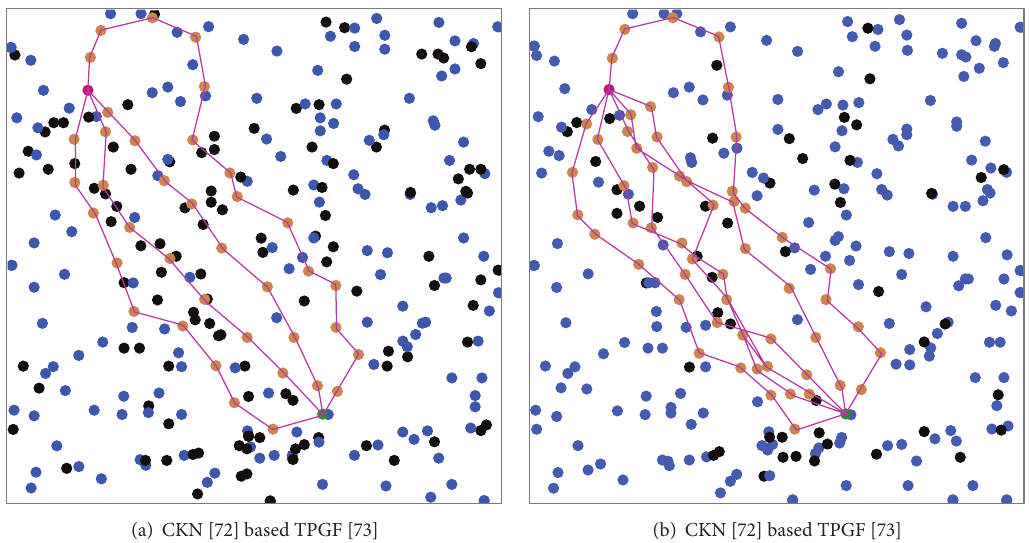
Figure 6: Duty cycle based sensor network using NetTopo [71] simulator (active nodes in blue/maroon, sleeping nodes in black, source node in red, and sink node in green color).